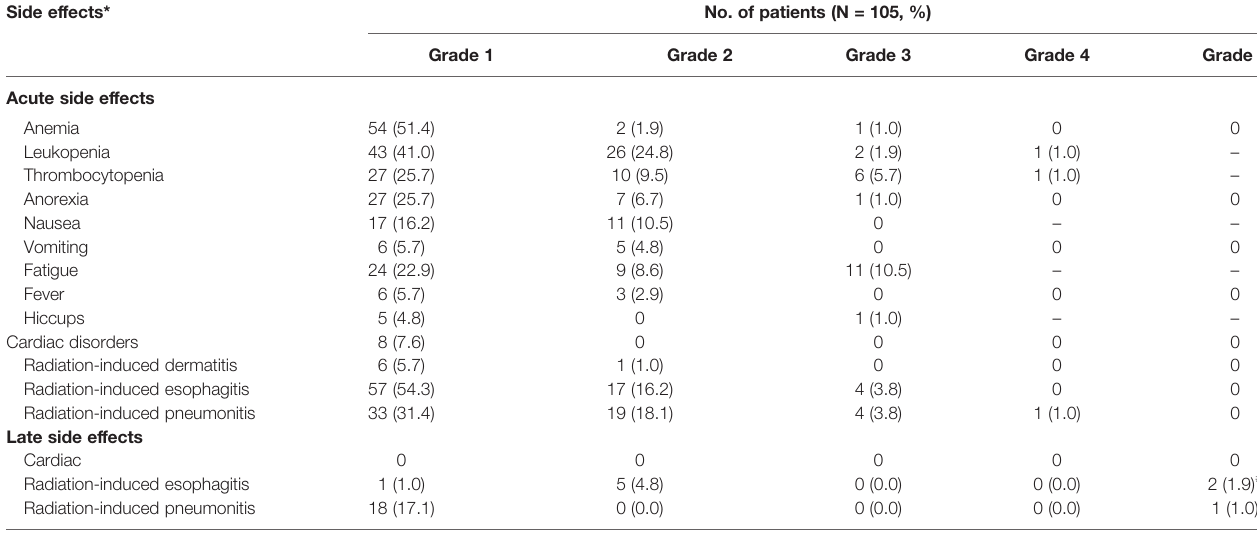
TABLE 3 | Side effects of patients